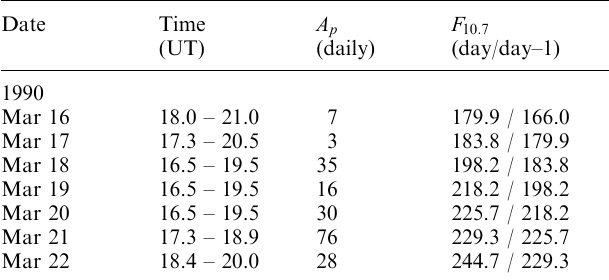
Table 1. List of time intervals of the March 1990 storm period used in the study. The three month average solar 10.7–cm flux was F 10 : 7 (cid:136) 184 : 1 (cid:2) 10 (cid:255) 22 Wm (cid:255) 2 Hz (cid:255) 1 .